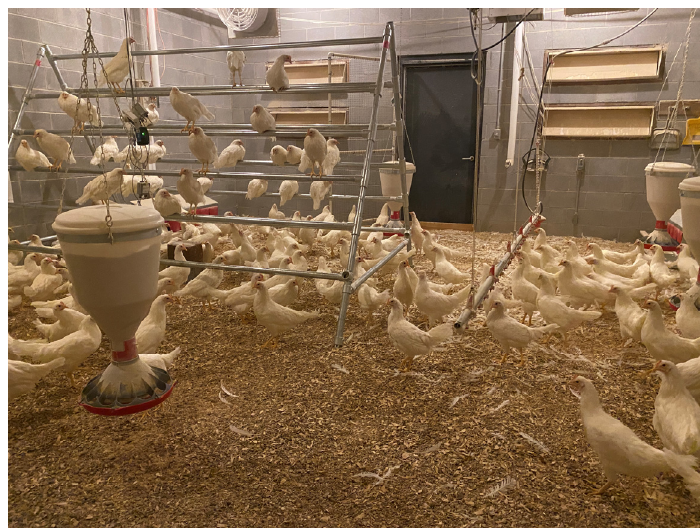
Figure 1. Experiment setup of cage-free research houses.